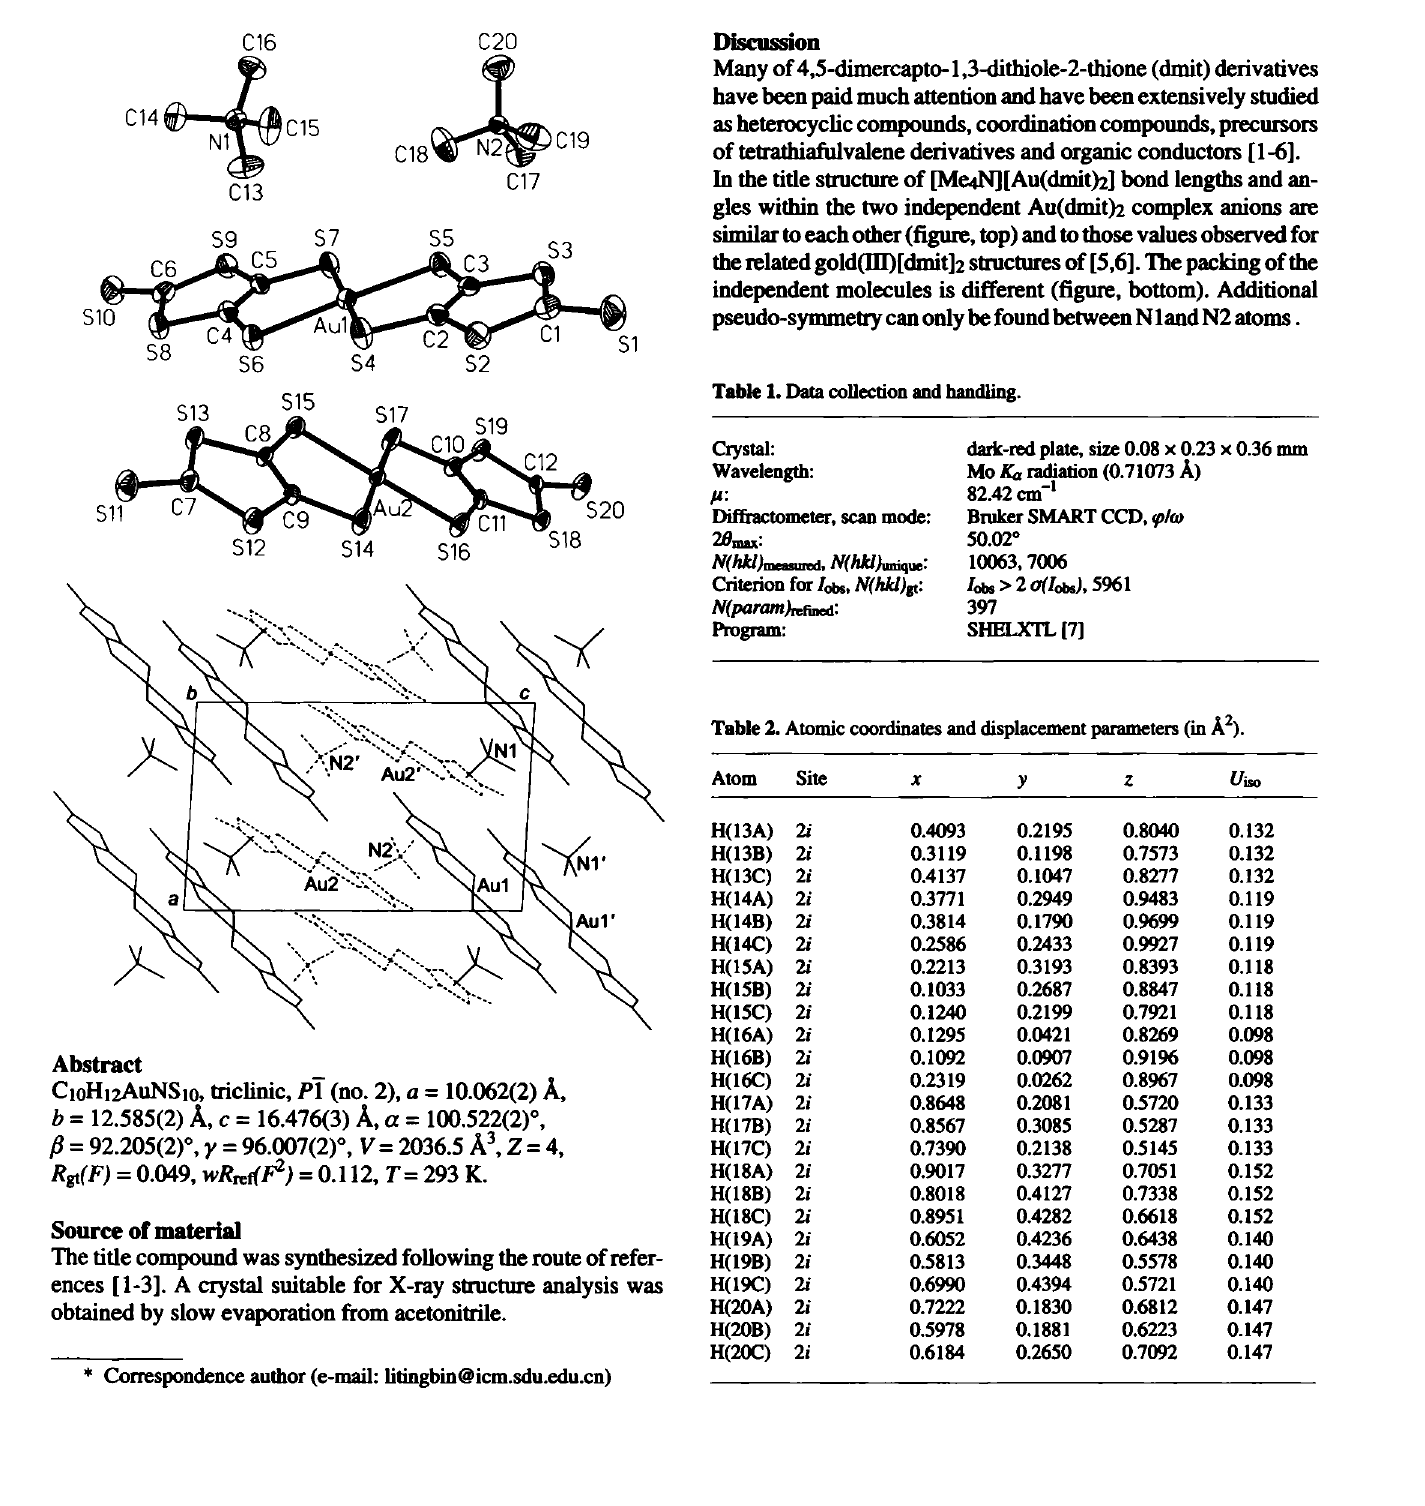
Table 1. Data collection and handling.